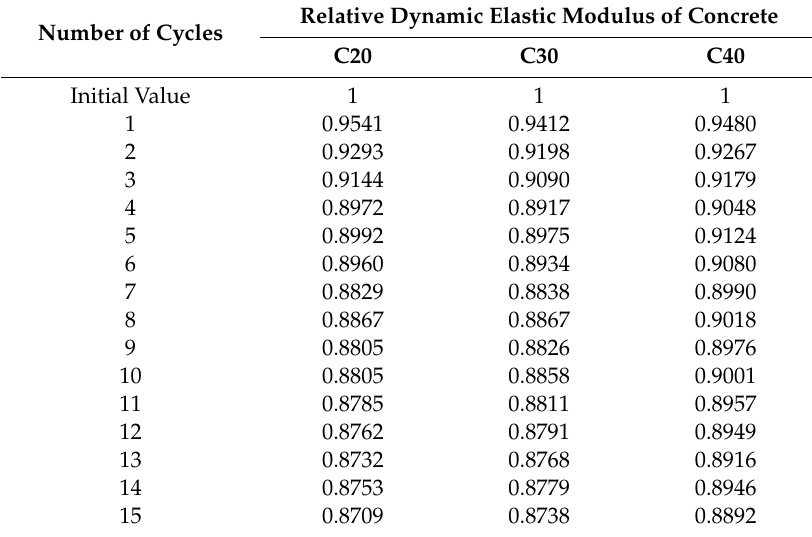
Table 6. Relative dynamic elastic modulus of concrete under periodic temperature-humidity. Number of